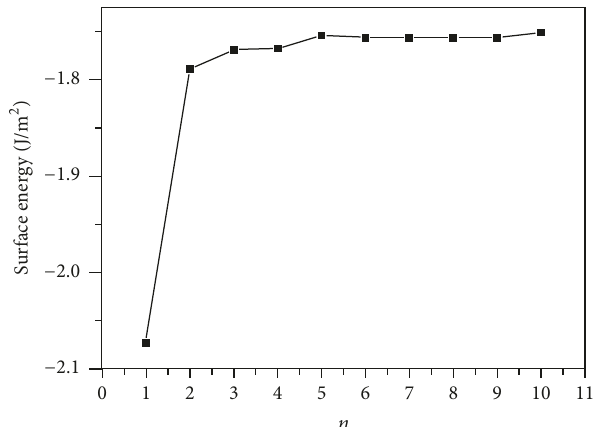
Figure 5: Variation of work functions of U(001) slabs as a function slab